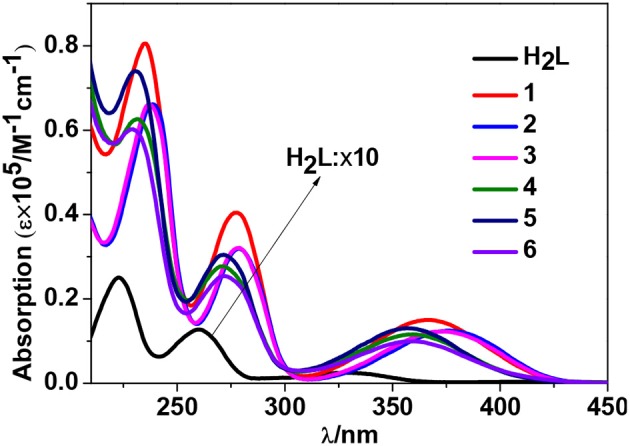
UV-Vis absorption spectra of the free Schiff base ligand H2L and 1-6 in CH3CN. (C = 10−6-10−5 M).